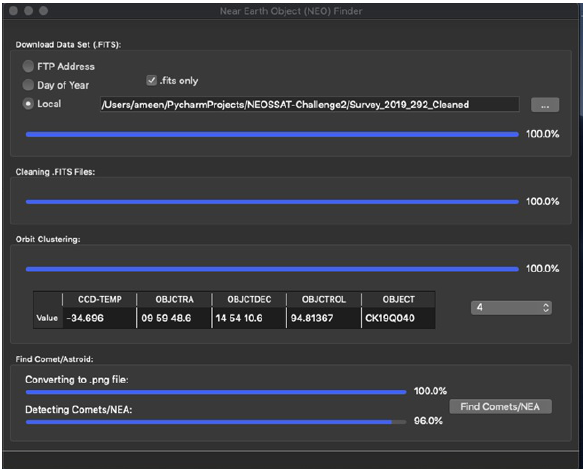
Figure 10. User interface of the developed software makes this technique